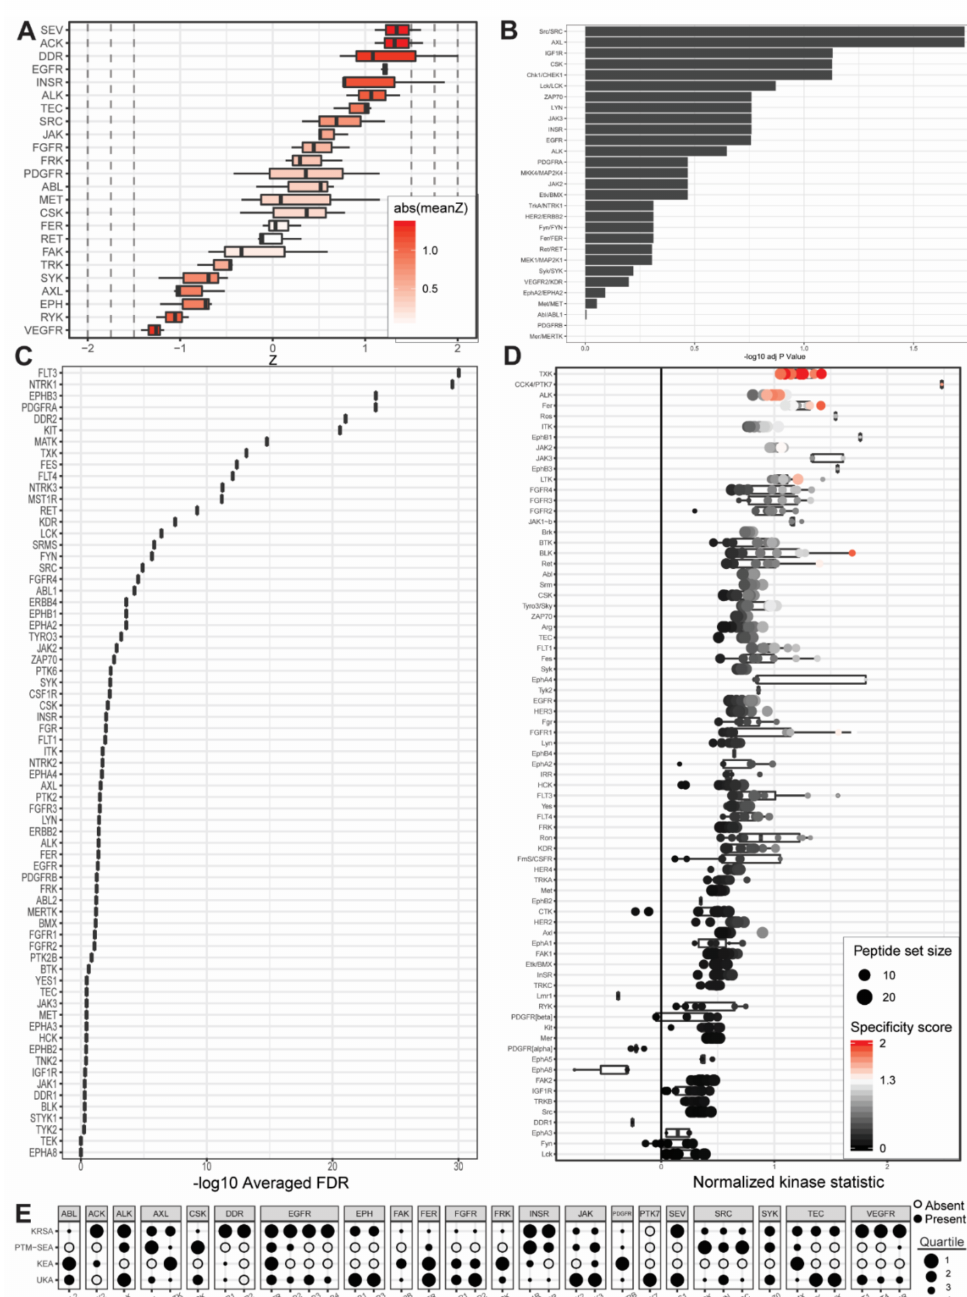
Figure 4. Outputs from upstream kinase identification pipelines for the patient-derived PDCL5 PDAC cell line compared to patient-derived wild-type pancreatic tissue. ( A ) Kinome Random Sampling Analyzer (KRSA); ( B ) Post-Translational Modification Signature Enrichment Analysis (PTM-SEA); ( C ) Kinase Enrichment Analysis Version 3 (KEA3); ( D ) Upstream Kinase Analysis (UKA). ( E )